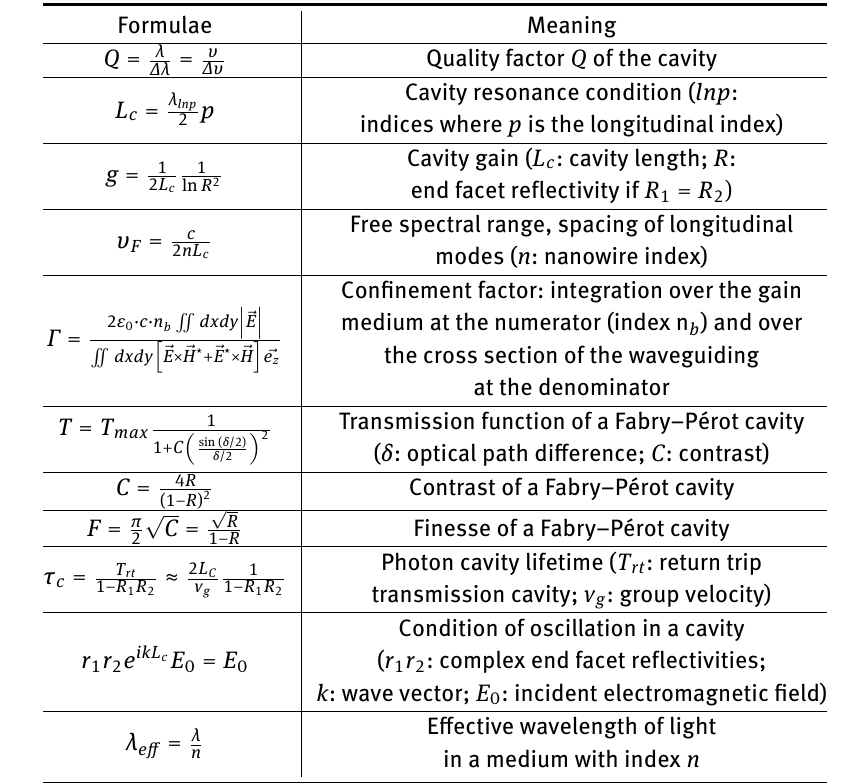
Table 2: Summary of relevant parameters and figures of merit in lasing